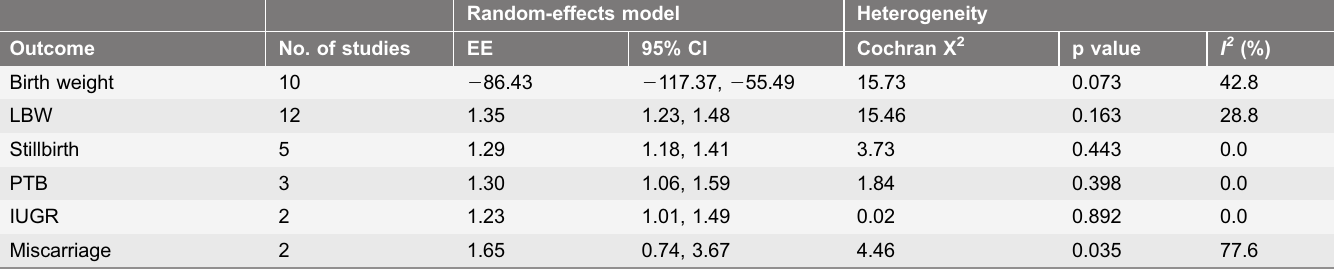
Table 3. Summary-effect estimates (EE) for the relation of solid fuel use with adverse pregnancy outcomes.